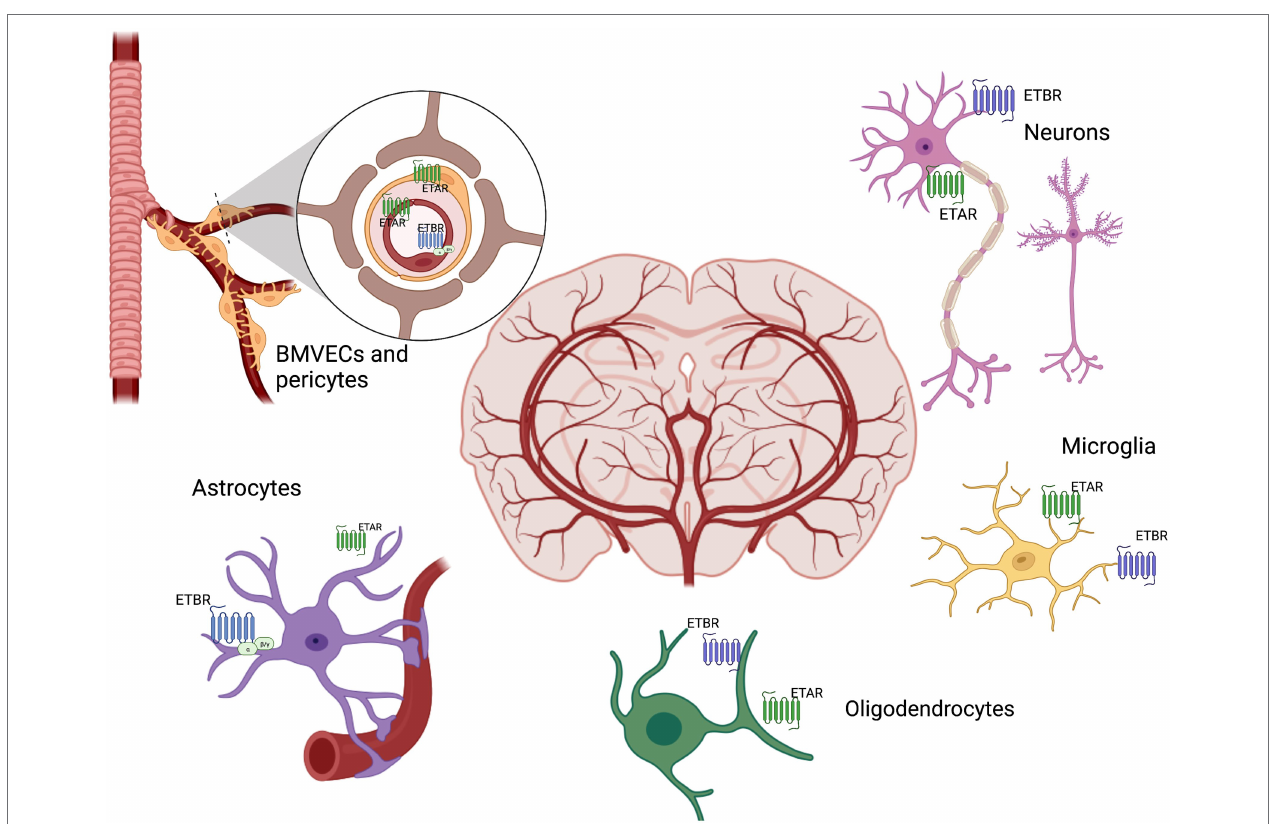
FIGURE 3 | Brain ET system. ET receptors are distributed throughout the brain in all components of the neurovascular unit, including neurons, brain microvascular endothelial cells (BMVECs), pericytes, astrocytes, microglia, oligodendrocytes. ET exerts both beneficial and adverse biological actions through its receptors ETAR and ETBR in the